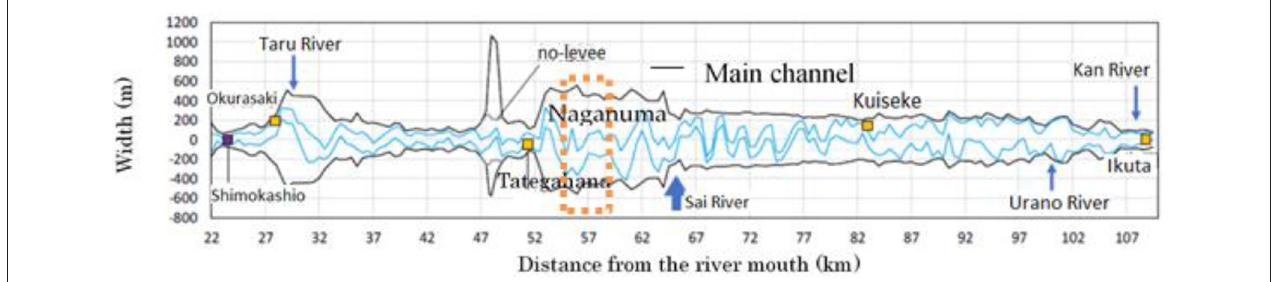
FIGURE 4 | The bottleneck in channel conveyance due to sudden contraction in width. (data source: